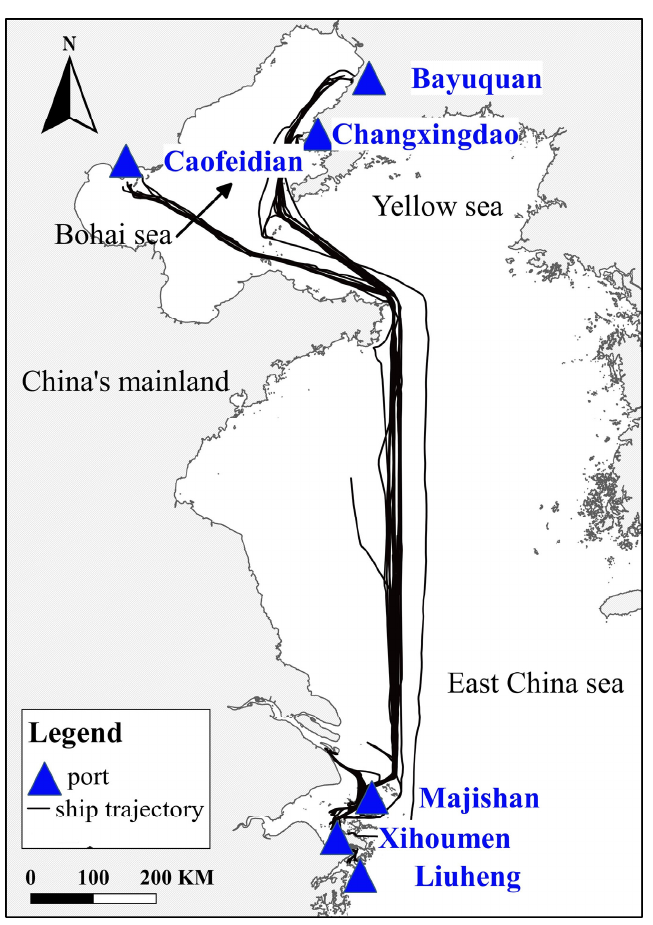
Figure 9. Ship trajectory in experimental